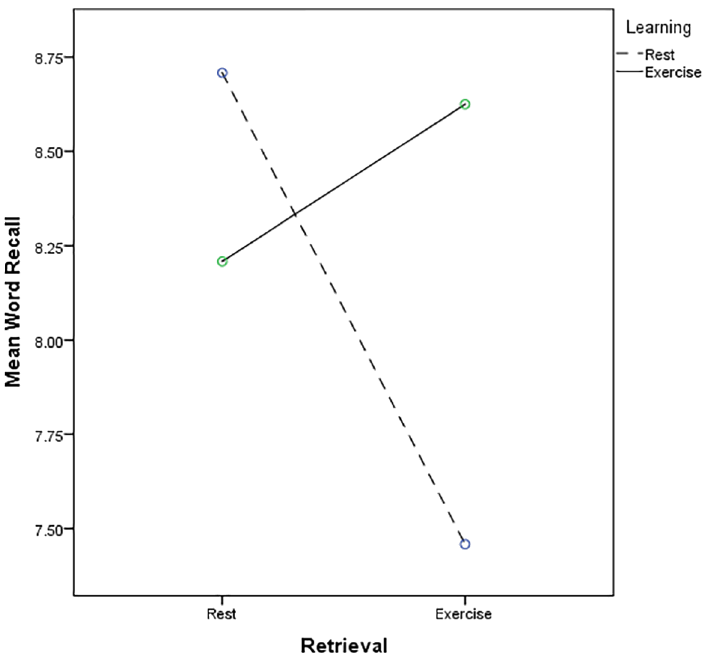
Figure 1. Mean number of words recalled across the 4-group encoding-specific